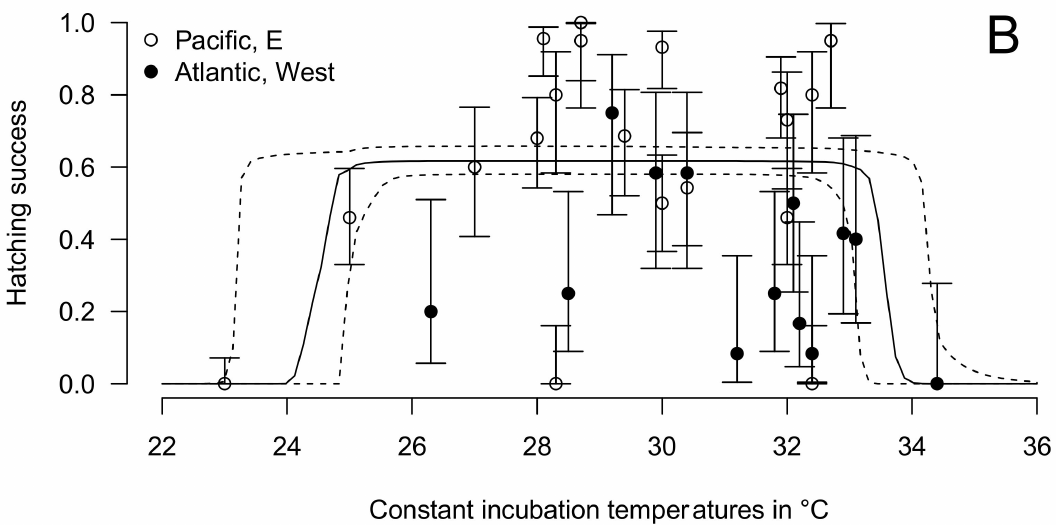
Figure 4. Sex ratio and hatching success at constant incubation temperatures. The thermal reaction norms for ( A ) sex ratio and ( B ) hatching success are shown in solid lines. Light gray temperatures in ( A ) are the range of temperatures that produced a sex ratio from 5% to 95% (transitional range of temperature 5%), and dark gray temperatures are the 95% credible regions for limits of the transitional range of temperature 5%. The temperature that produced 50% of each sex (pivotal temperature) is shown by the interrupted vertical line. In both graphs, the 95% credible regions of the thermal reaction norm are shown with dashed lines. Each point represents a set of eggs from the same origin at a specific constant